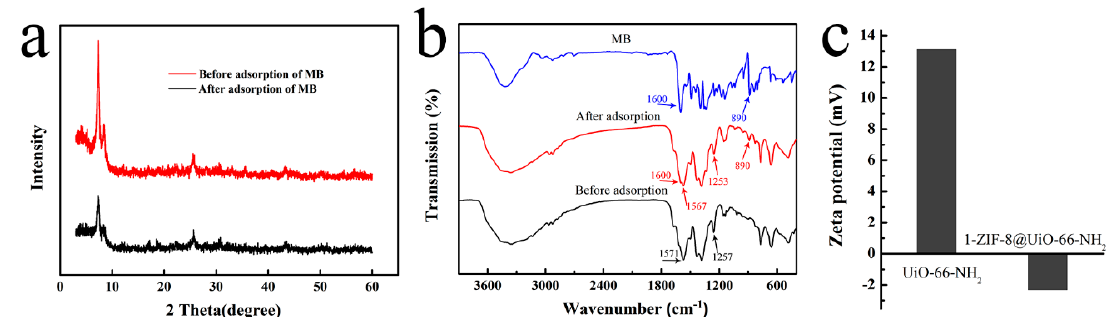
Figure 12. ( a ) X-ray diffraction (XRD) and ( b ) Fourier transform infrared spectroscopy (FT-IR) of zeolitic imidazolate framework-8 (ZIF-8)-loaded UiO-66-NH 2 before adsorption and recovered after adsorption of methylene blue (MB), and ( c ) zeta potentials of UiO-66-NH 2 and ZIF-8-loaded UiO-66-NH 2 . Table 7. Structure of dyes.